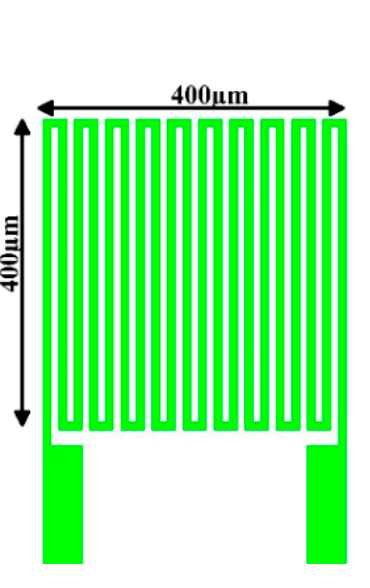
Figure 1. Principle and design of micro-temperature sensor.